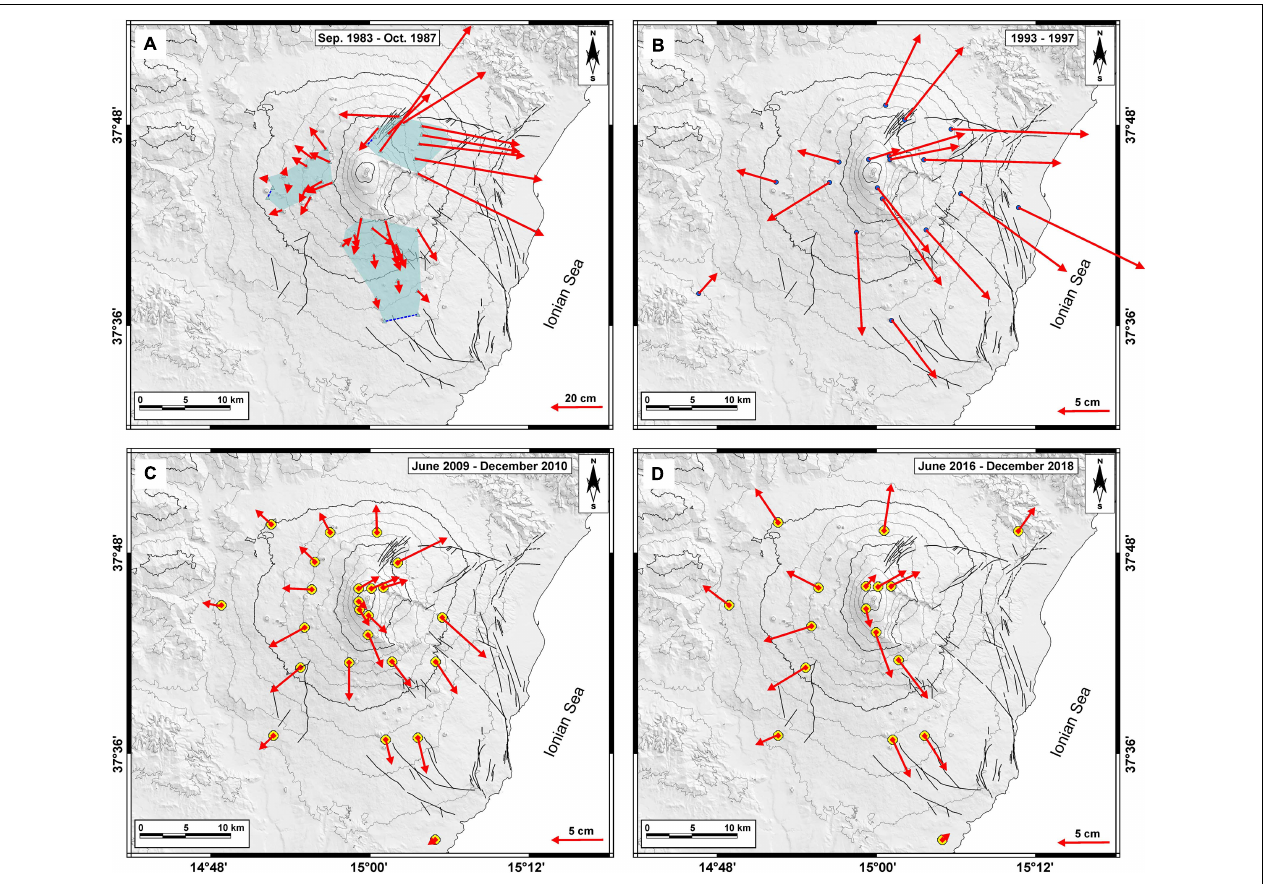
FIGURE 2 | Displacement vector patterns of inflation phases in different periods obtained by deformation geodetic monitoring networks. (A) 1983–1987 inflation and dominant eastern flank sliding from EDM measurements. (B) 1993–1997 inflation from GPS periodical measurements. (C) 2008–2009 and (D) 2016–2018 inflation from continuous GPS permanent network